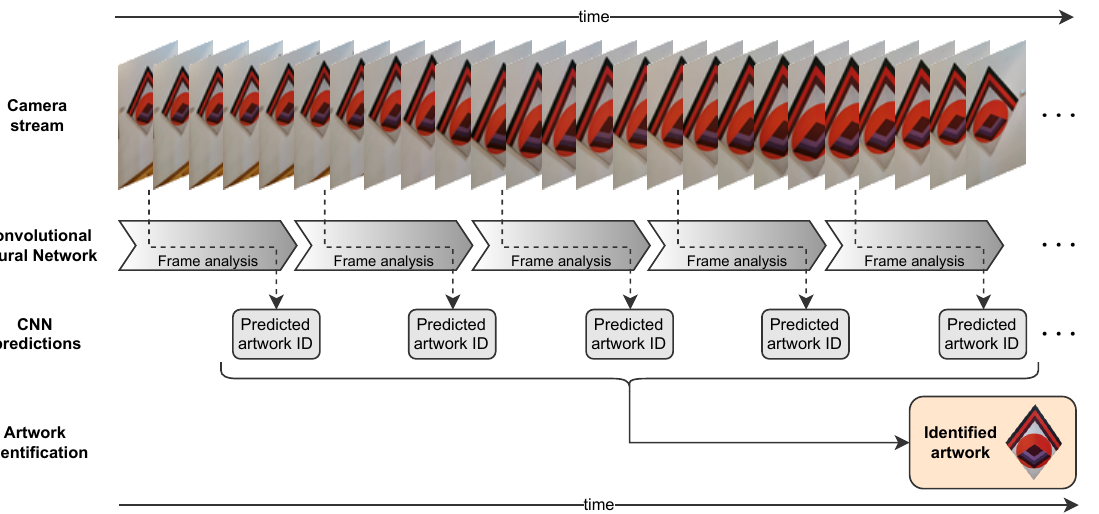
Figure 11. The process used for artwork identification: while the user is pointing at an artwork, the embedded CNN is used to continuously analyze individual frames from the phone’s camera stream. The app considers a sliding window of 5 CNN predictions and picks the artwork with the highest mean probability in the window as the correct